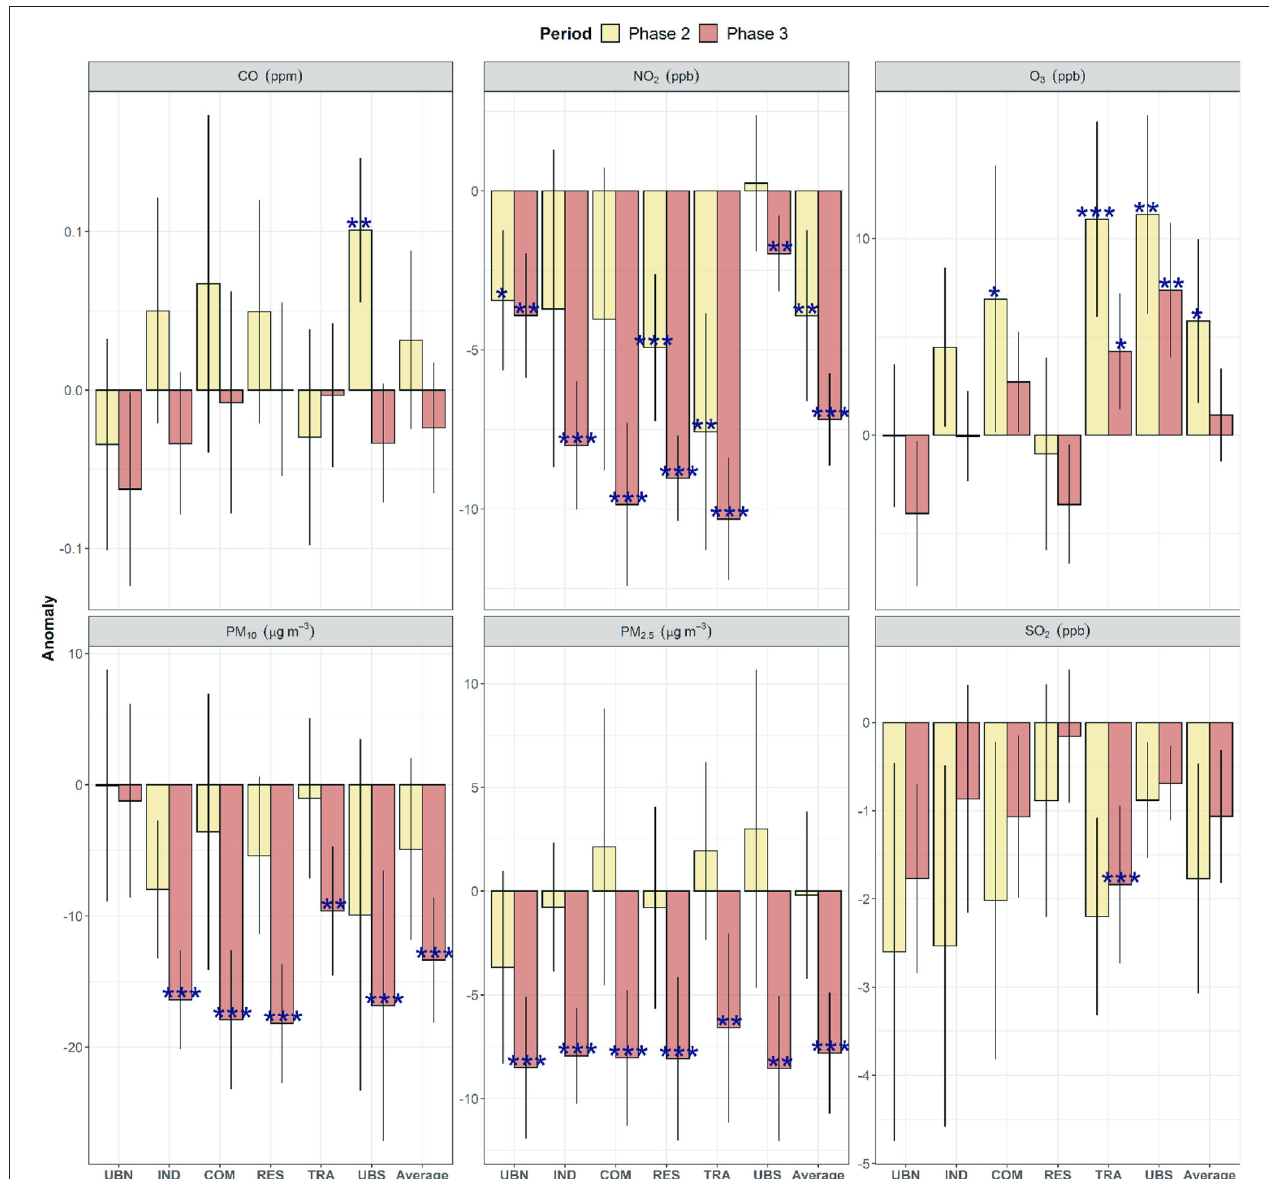
FIGURE 6 | Net changes in anomalies of criteria air pollutants during lockdown Phases 2–3 in comparison to 2016–2019 anomalies as baseline within the MCMA. The stars show significant changes during the COVID-19 lockdown calculated with the non-parametric Wilcoxon test, while the vertical bars show the 95% confidence intervals. *Level of significance p < 0.05. **Level of significance p < 0.01. ***Level of significance p <